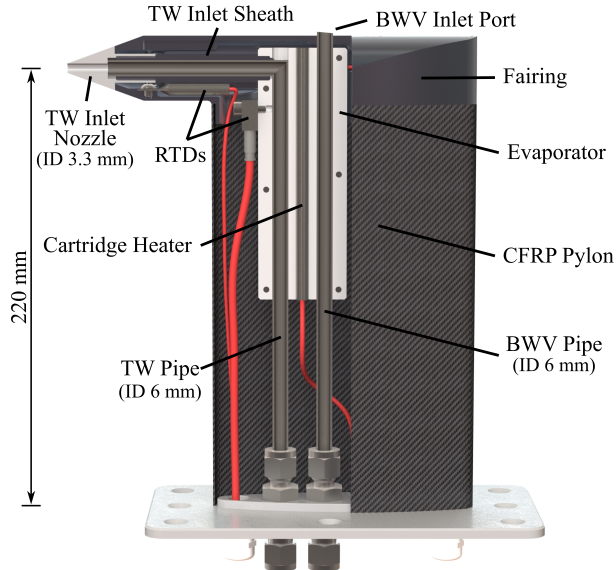
Figure 2. Schematic of the isokinetic evaporator probe assembly showing a partial cut through the main components: TW and BWV inlet lines with TW inlet nozzle, the carbon fiber reinforced polymer (CFRP) pylon, aluminum fairing, and evaporator. Fairing cartridge heaters extending alongside the TW inlet sheath are not